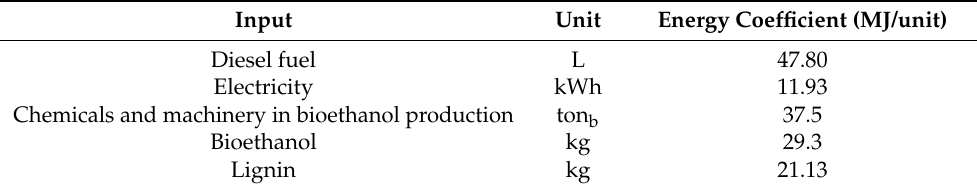
Table 4. Energy coefficients for different inputs and outputs to the bioethanol production